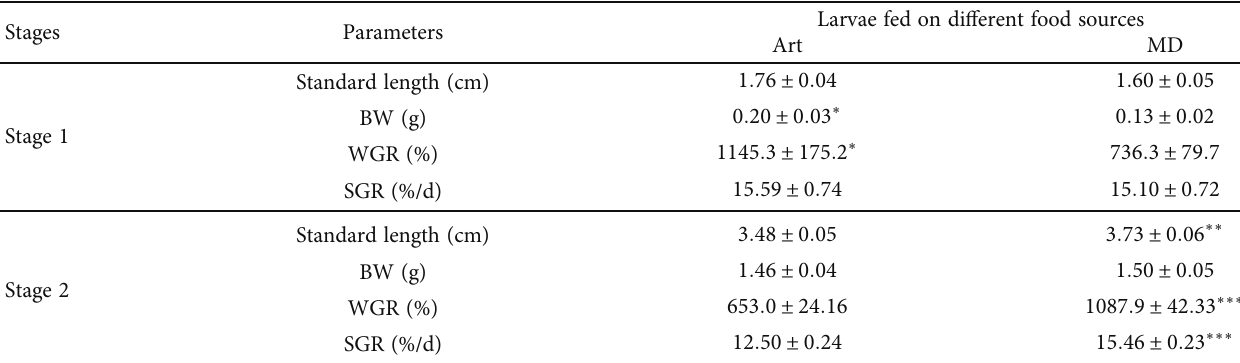
Table 4: Growth performance and body indices of 40 dph and 55 dph rock bream